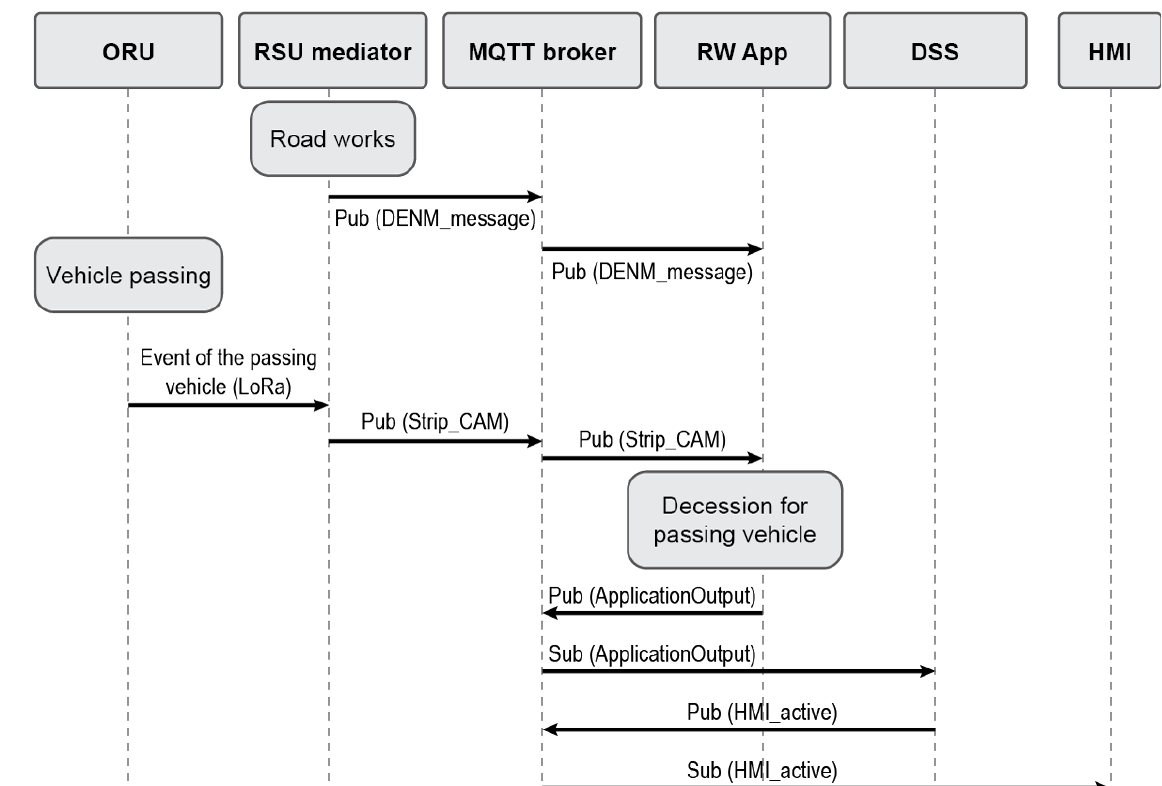
Figure 3. Warnings & messages flow architecture example.